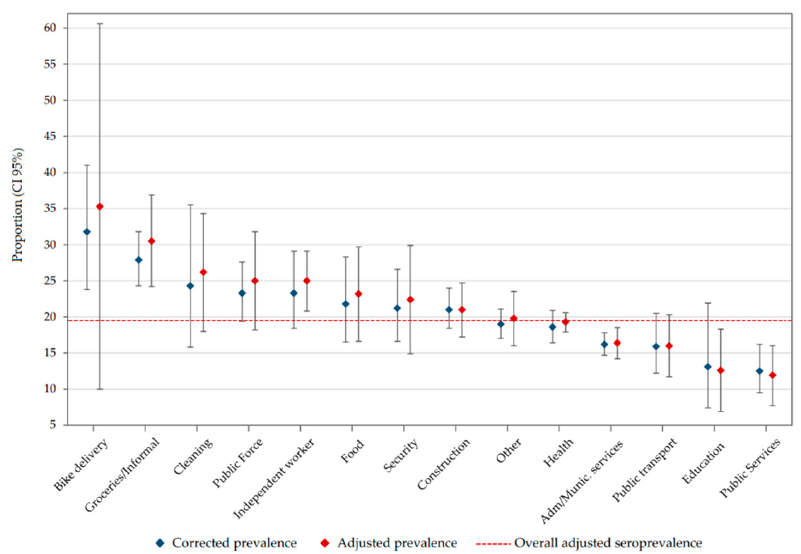
Figure 4. Seroprevalence according to occupational group. Dashed line represents the overall adjusted seroprevalence estimated in our study. This line was added for comparison purposes.